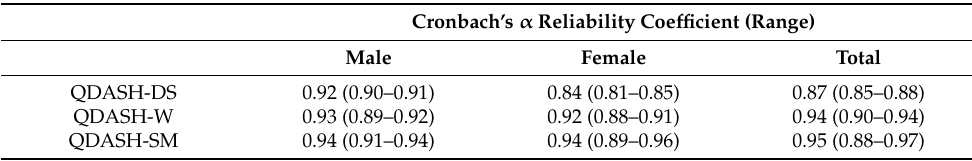
Table 4. Internal consistency of QuickDASH between males and